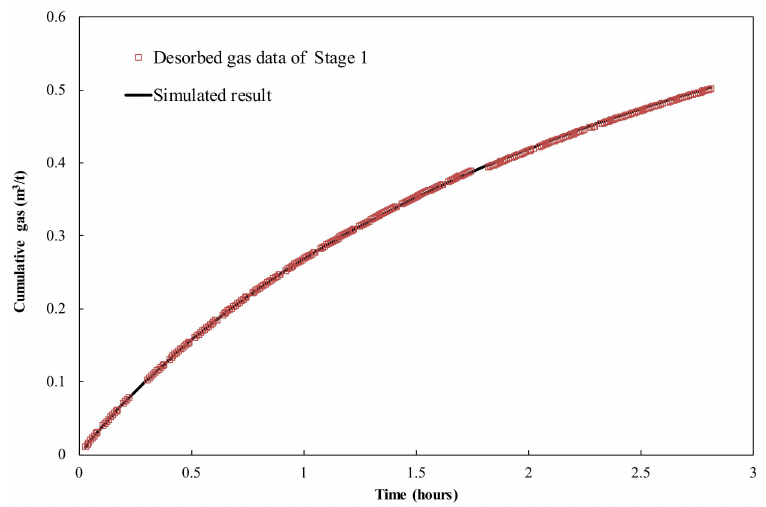
Figure 6. Results of the first-stage cumulative gas volume modeling using Equation